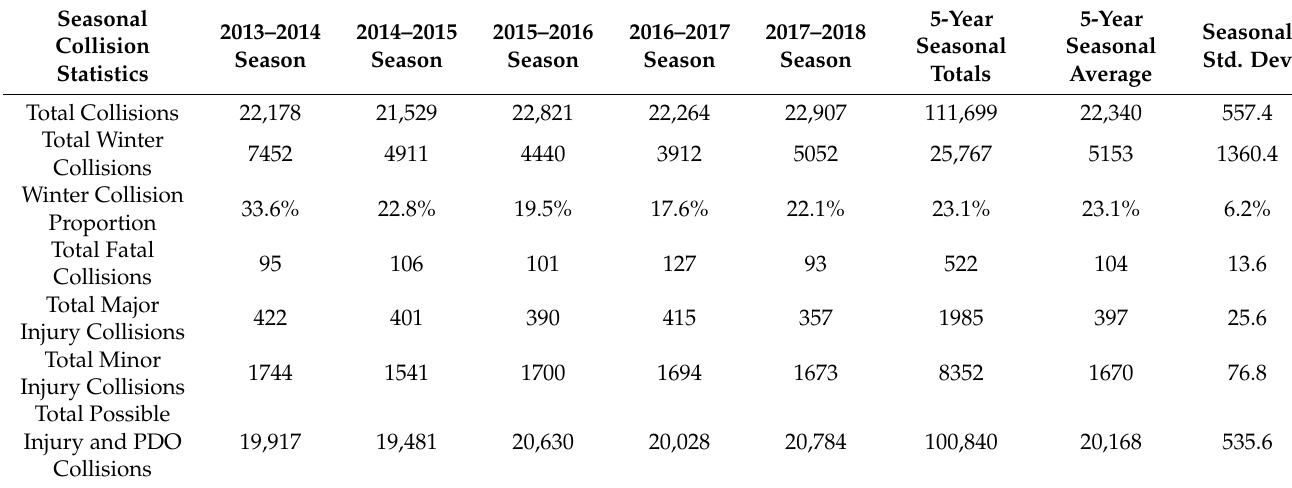
Table 2. Seasonal collision